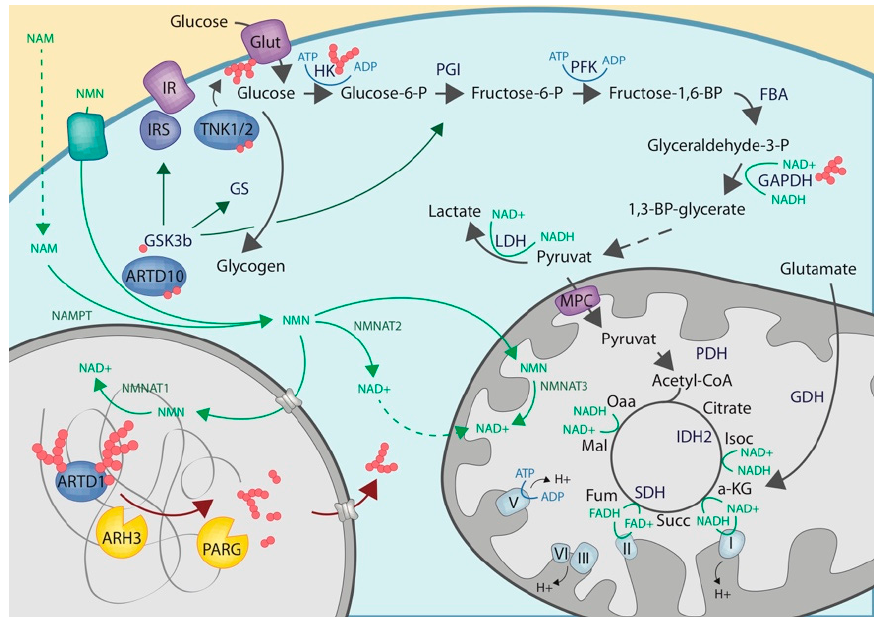
Figure 2. Schematic overview on the functional contribution of cytoplasmic ARTs to carbohydrate metabolism. Metabolic pathways are shown as in Figure 1. ADP-ribosyltransferases are depicted in blue, while ADP-ribosylhydrolases are depicted in yellow.